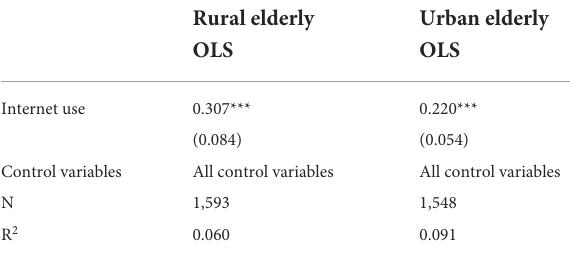
TABLE 7 Heterogeneity